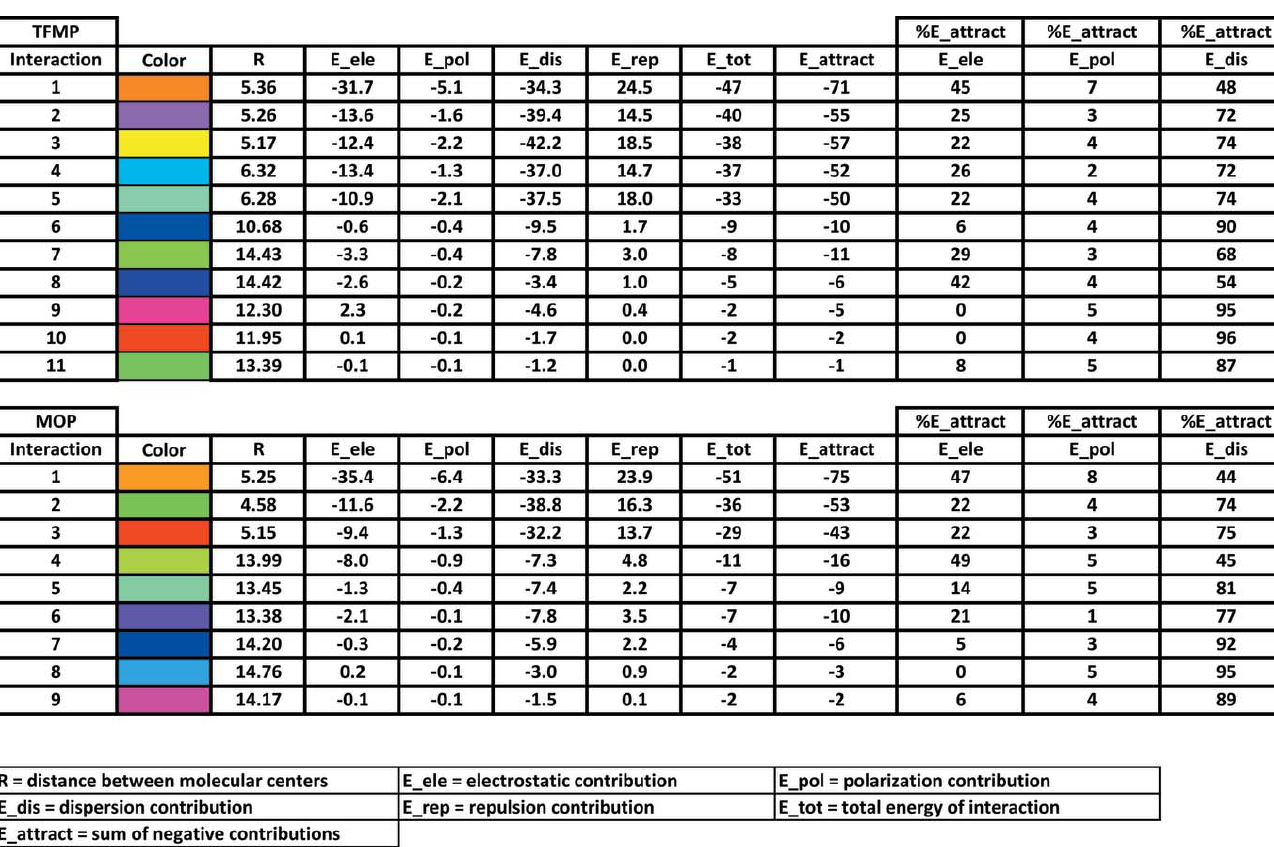
Figure 9 Key for the intermolecular interaction energies for TFMP and MOP . Energy units are kJ mol (cid:5) 1